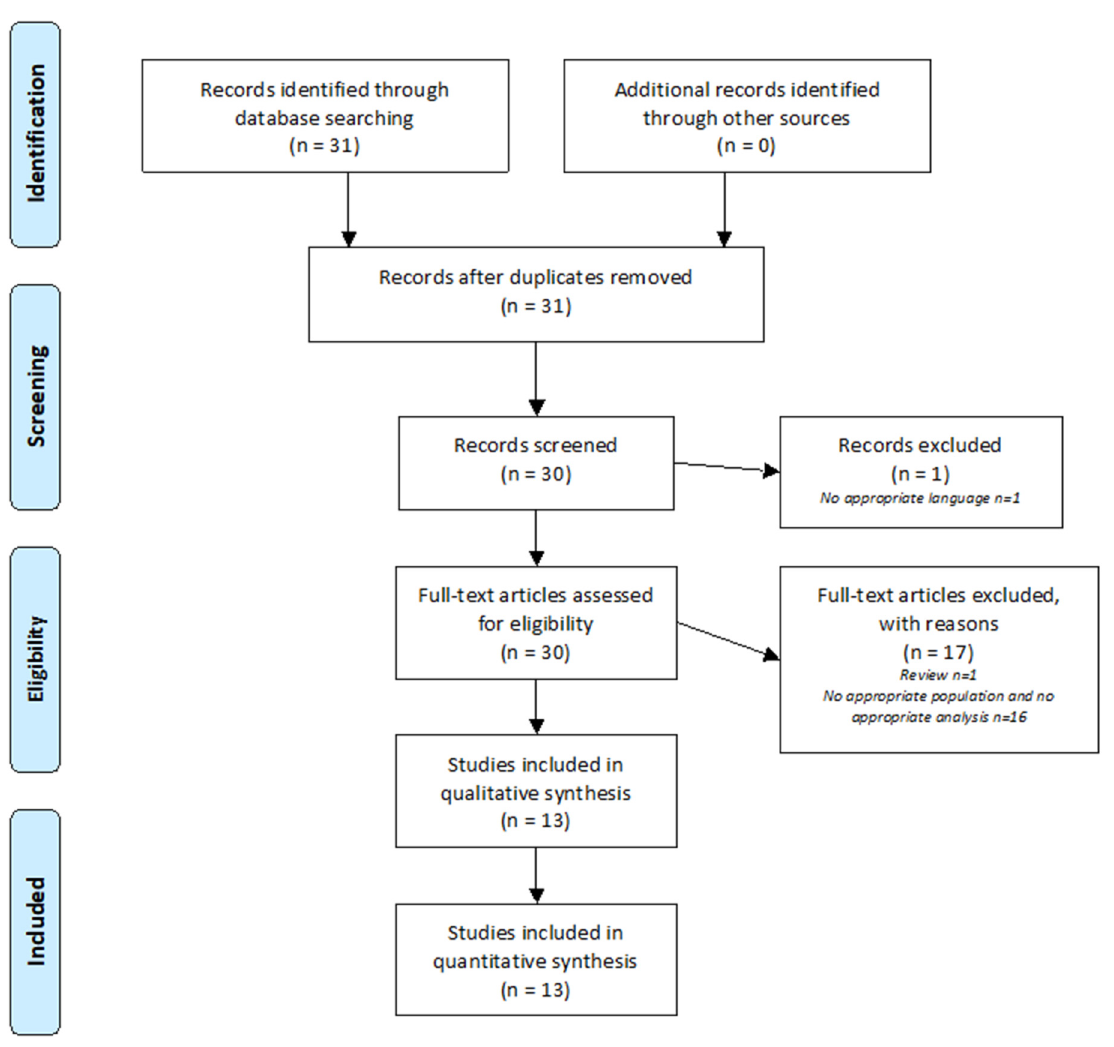
Figure 1. PRISMA Flow Diagram. The PRISMA diagram details the search and selection process applied during the